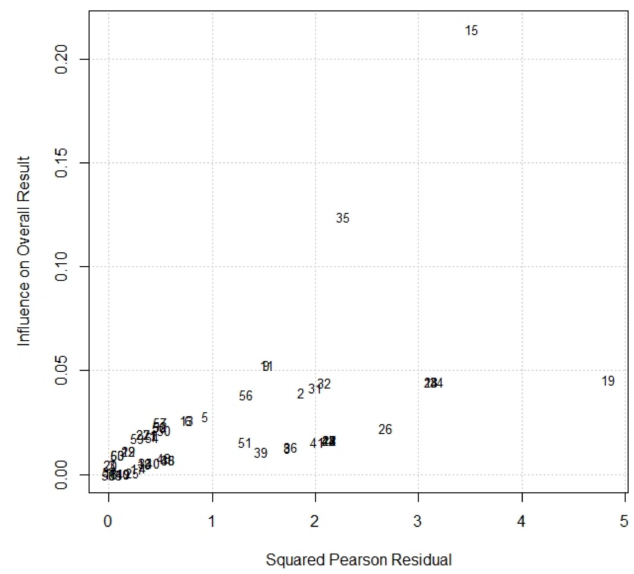
Figure A1. The Baujat Plot of roe deer studies. Study number 5 [90] could be an outlier which may distort the effect size estimate, as well as its precision.